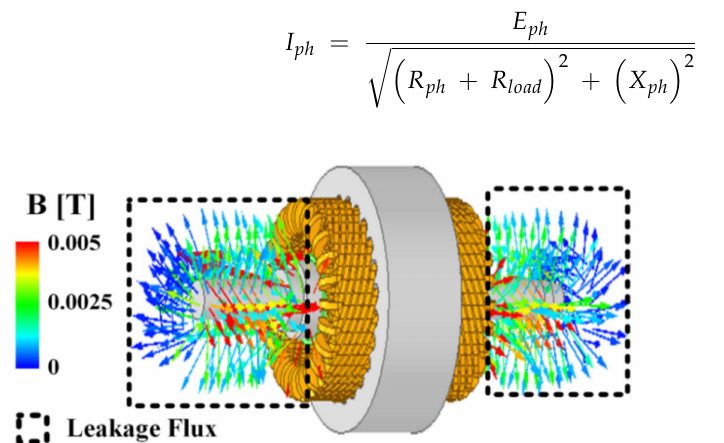
Figure 5. Leakage magnetic flux of STS420-J2 shaft material.